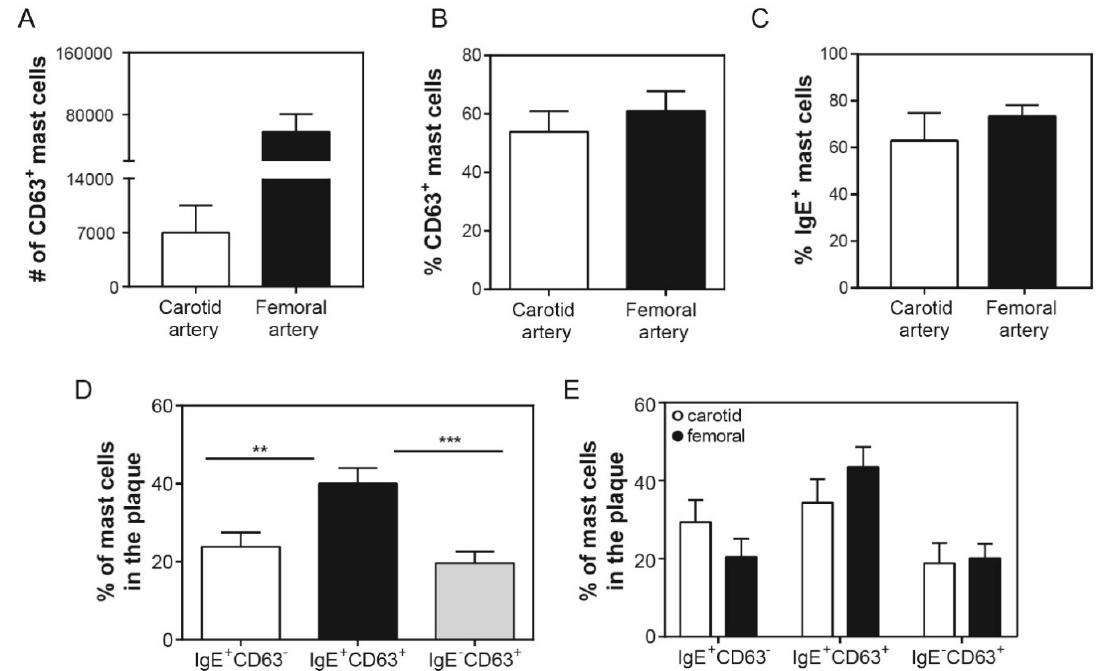
Figure 3. Activation of human intraplaque mast cells. ( A ) Number of activated mast cells, as defined by marker CD63, inside the carotid and femoral artery human plaques. ( B ) Percentage of activated mast cells in human atherosclerotic plaques. ( C ) Percentage of IgE + mast cells in human atherosclerotic plaques. ( D ) Percentage of IgE + CD63 - , IgE + CD63 + , and of IgE - CD63 + mast cells of both carotid and femoral human atherosclerotic plaques combined. ( E ) Percentage of IgE + CD63 - , IgE + CD63 + , and of IgE - CD63 + mast cells displayed separately for carotid and femoral arteries, showing a similar pattern per plaque location. Data are depicted as mean ± SEM; A, B, C, and E: n = 10–12/grp; D: n = 22.